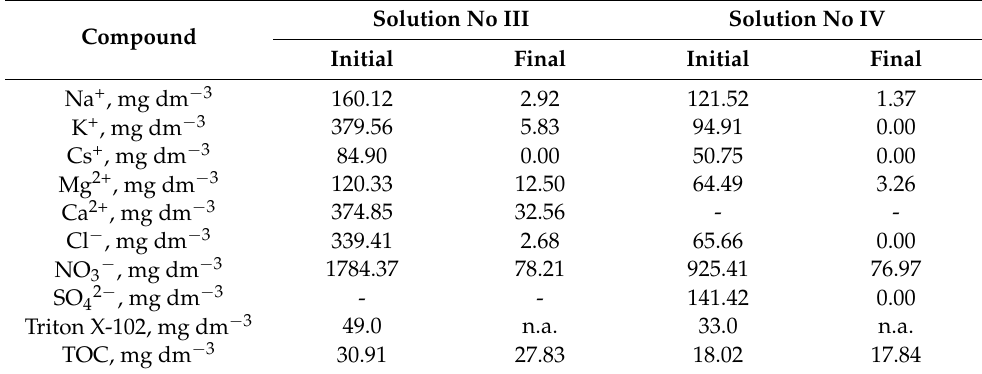
Table 4. The treatment of model solutions containing Triton X-102 using